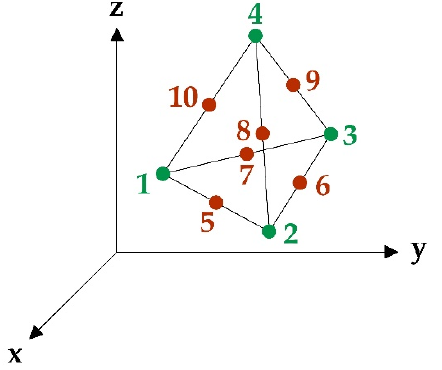
Figure 16. Geometry of tetrahedral element CCIso Tetra [40].